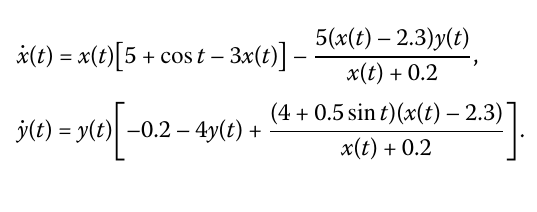
then condition (2.1) and (2.2) are satisfied. According to Lemma 2.2, the system (1.4) is permanent. Numerical simulation (see Fig. 1 and Fig. 2) also supports this